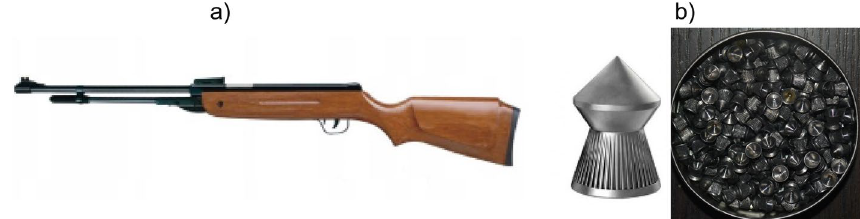
Fig. 1 a KANDAR B3‑3 airgun. b Diabolo pellet and metal box with 5.5‑mm